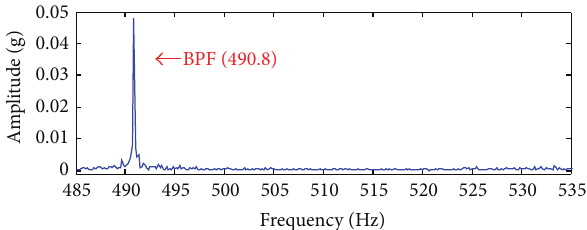
Figure 9: Zoomed-in spectrum under 32 mm crack condition.